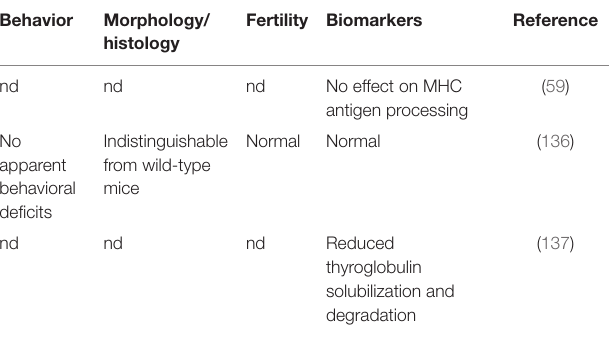
TABLe 2 | Animals lacking the cathepsin B gene are